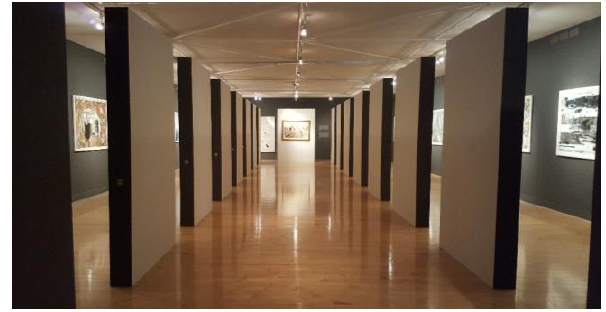
Figure 2. Crafted paper notebook